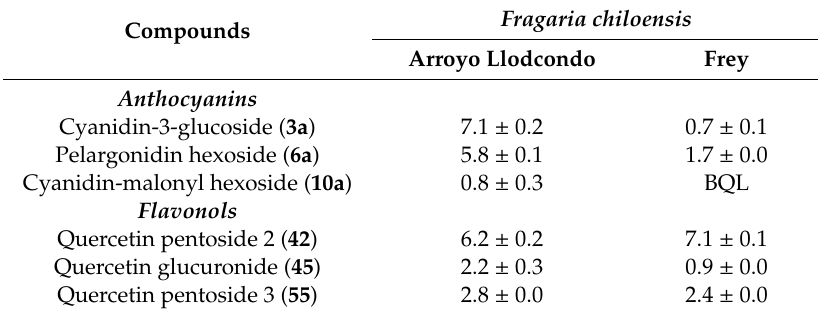
Table 4. Anthocyanins and flavonols content of wild Fragaria chiloensis from the Argentinean Patagonia. Data are expressed as mg / 100 g fw. Fragaria chiloensis Compounds Arroyo Llodcondo Frey Anthocyanins Cyanidin-3-glucoside ( 3a